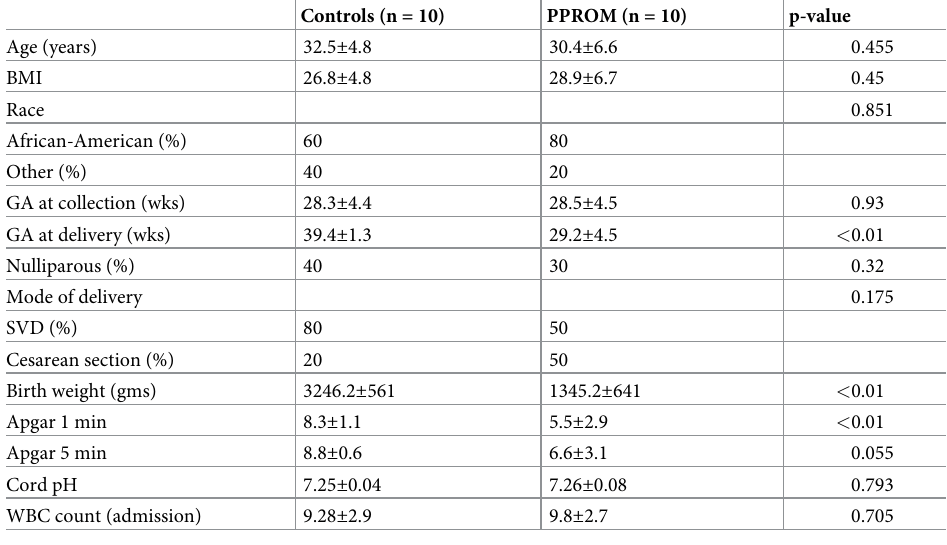
Table 1. Demographic characteristics.